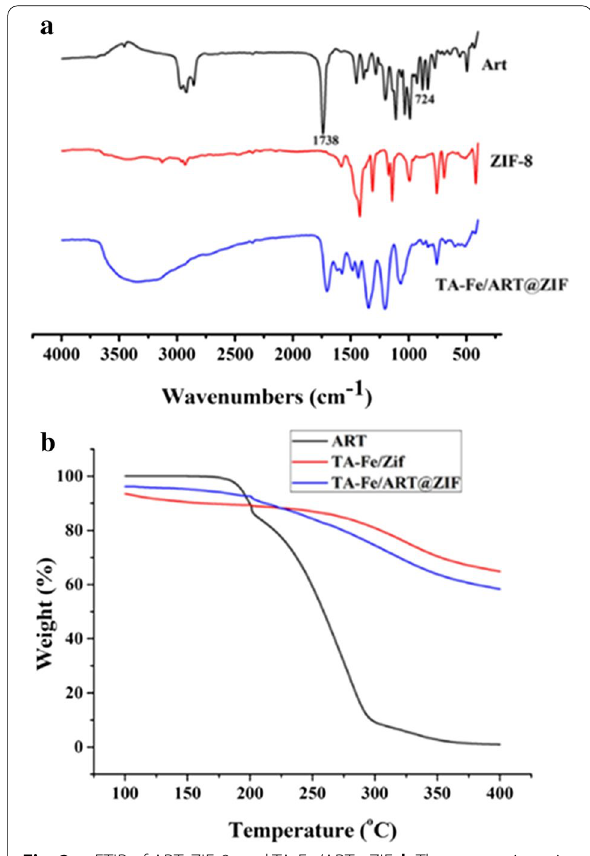
Fig. 2 a FTIR of ART, ZIF-8, and TA-Fe/ART@ZIF; b Thermogravimetric analysis (TGA) of ART, TA-Fe/ZIF, and